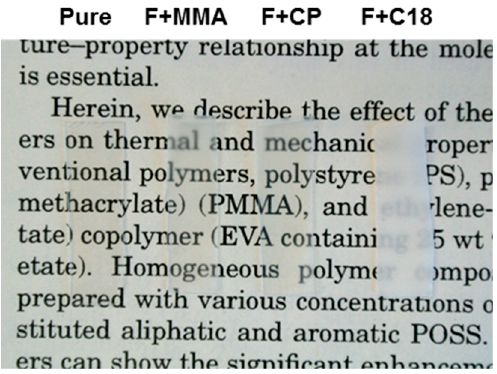
Table 1. Summary of the filler effects on the various properties of the PMMA, by the POSS fillers a.